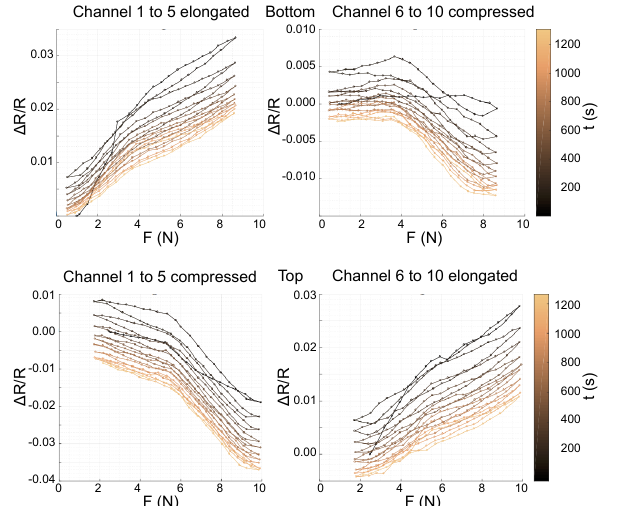
Figure 11. Repetitive mechanical loading of the strain gauges. Rel- ative resistance change versus load with colour-coded time (Welle- weerd,